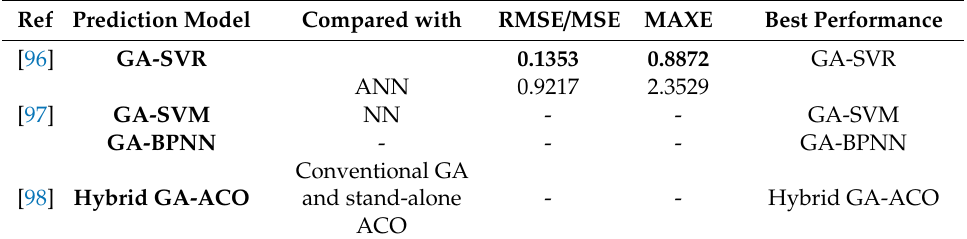
Table 5. Comprehensive analysis of soft sensor models based on genetic algorithms (for the list of abbreviations see Table